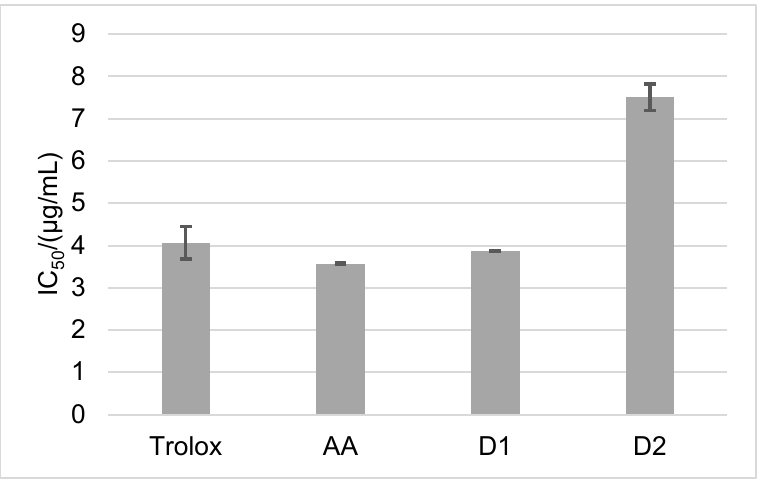
Figure 3. DPPH antioxidant activity of Trolox, AA, NH 2 AA (D1), and CH 3 NHAA (D2) on day 0. Results are expressed as µg/mL ± standard deviation (SD).